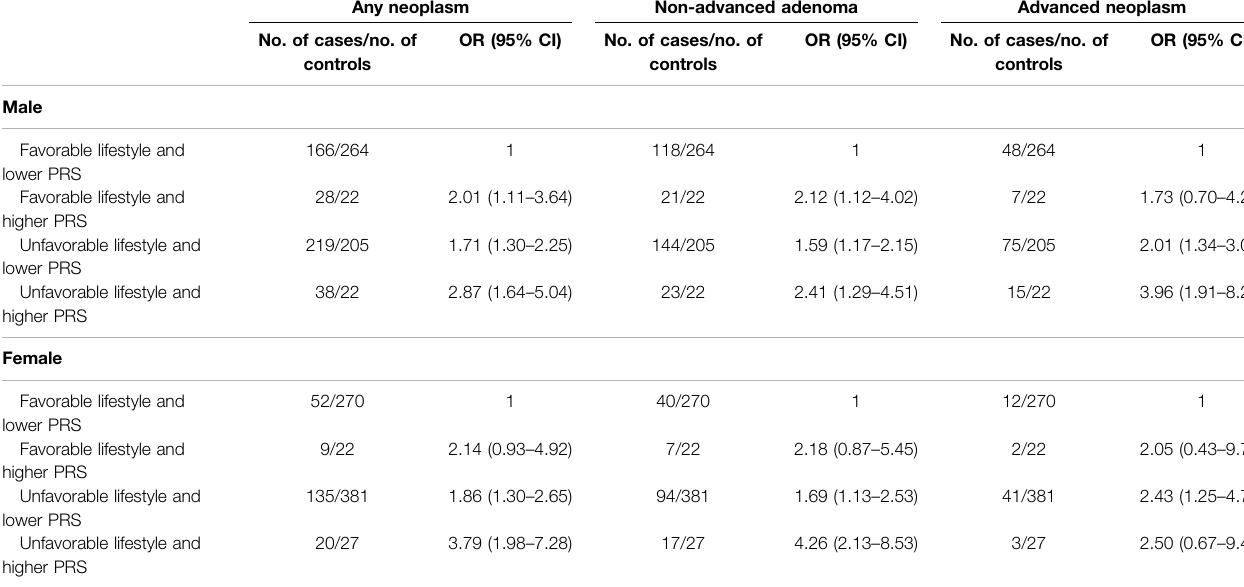
TABLE 2 | Odds ratios of risk pro fi les with colorectal neoplasm, non-advanced adenoma, and advanced neoplasm strati fi ed by sex. Any